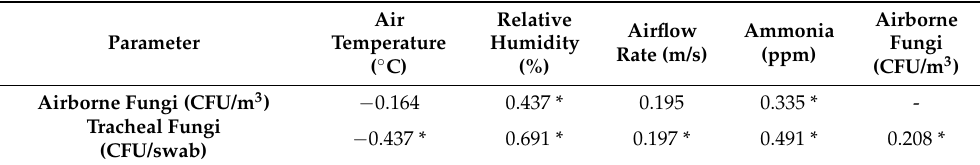
Table 4. Correlation between house microclimate parameters, and airborne and tracheal fungi.